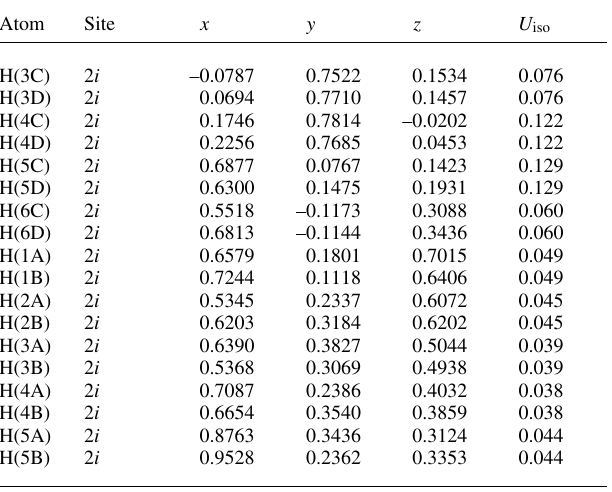
Table 2. Atomic coordinates and displacement parameters (in Å 2 ) .